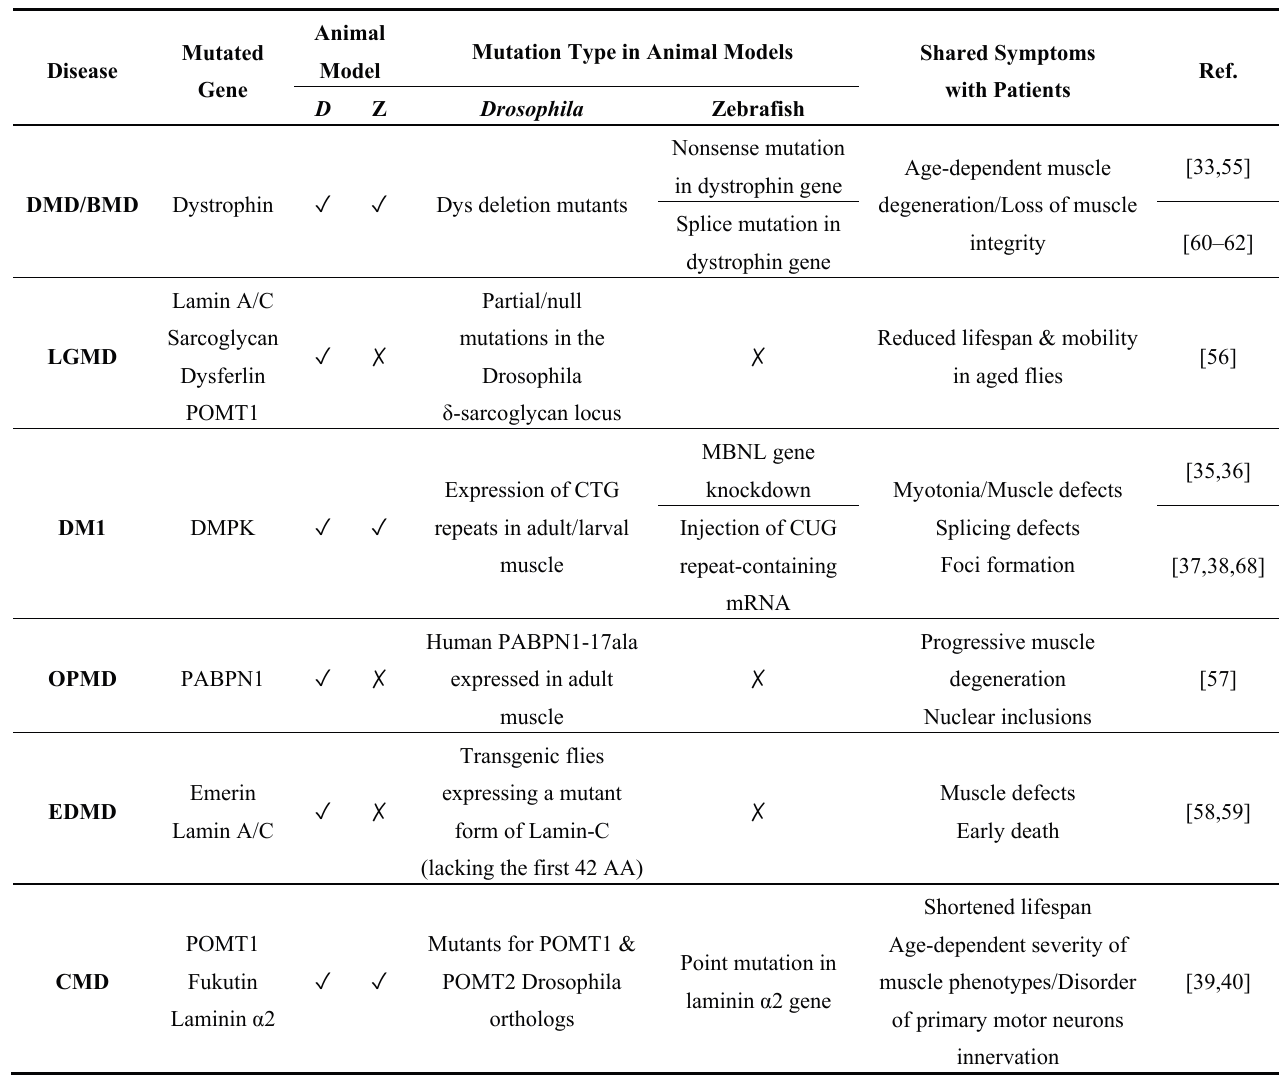
Table 1. Major Muscular Dystrophies (MD) modelled in Drosophila and